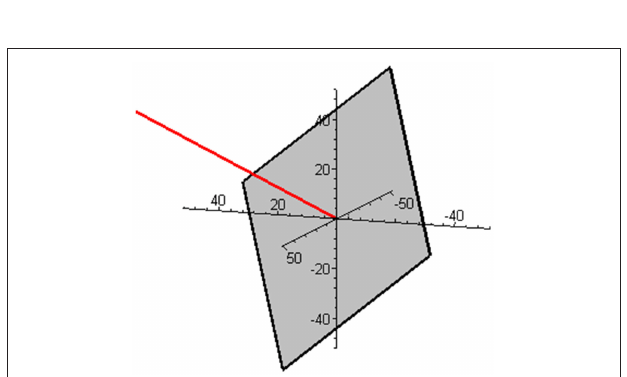
FIGURE 1 | The component space with the molar masses vector (red) and with the example of the reaction rate vector ( − 50, 30, 20) (black) corresponding to Equation (3) for a mixture of butene isomers (and unit base vectors).